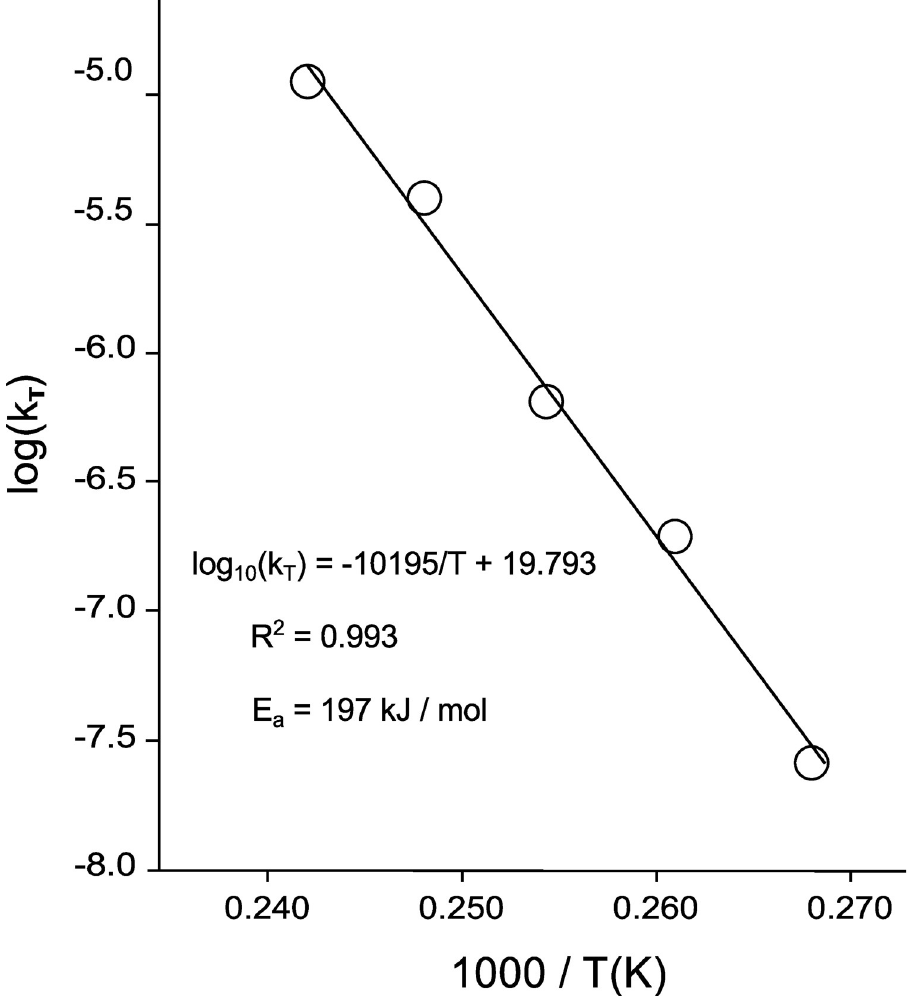
Fig 5. Arrhenius plot for DNA degradation in DNAshells. The degradation rate constants, k, were plotted as a function of the reverse of the absolute temperature T.